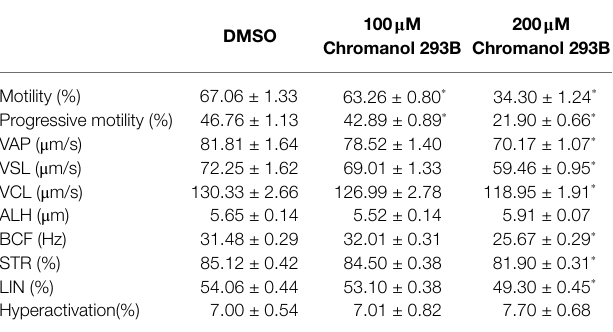
TABLE 1 | Effect of chromanol 293B on motility parameters during human sperm capacitation. Values represent the means ± SEM of 5